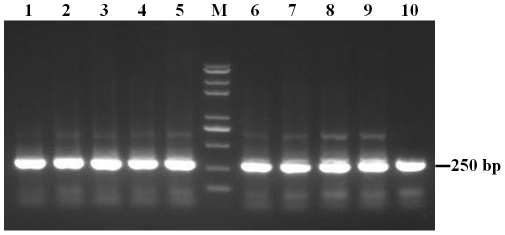
PCR amplifying genes encoding heterologous peptides in the recombinant phages.Using specific M13 phage primers, the genes encoding the heterologous peptides in the ten recombinant phages were amplified by PCR. The gel agarose electrophoresis of PCR product is provided. The PCR product from each phage clone is numbered 1 to 10 and lane M is DNA marker.